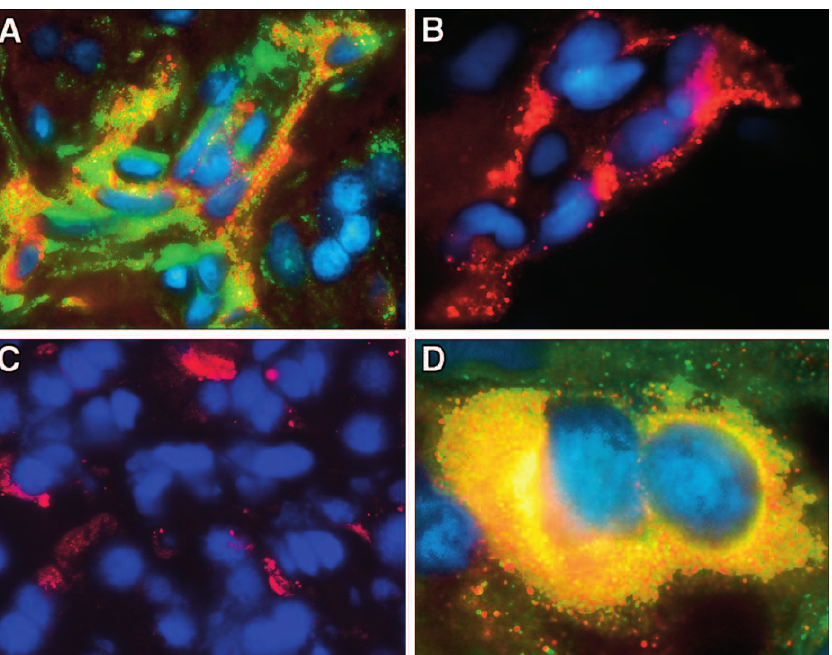
Figure 2. Immunofluorescent Characterization of the Neoplastic Stromal Cells in Hemangioblastoma Tissue Sections (A) Neoplastic cells express the mesodermal marker, brachyury (green), Flk-1 (VEGF receptor-2; red), and the nuclear stain 4 9 ,6-diamidino-2-phenylindole (DAPI) (blue). Coexpression of brachyury and Flk-1 (VEGF receptor-2) indicates that these cells are embryologic hemangioblasts. (B) Expression of Scl (red) by the neoplastic cells indicates that these are hematopoietic stem cells committed to hematopoietic and endothelial lineages. (C) The neoplastic cells demonstrate scattered cytoplasmic expression of the hematopoietic stem cell antigen CD133 (red). (D) Coexpression of the erythropoietin (green) and erythropoietin receptor (red) was uniformly demonstrated on the neoplastic